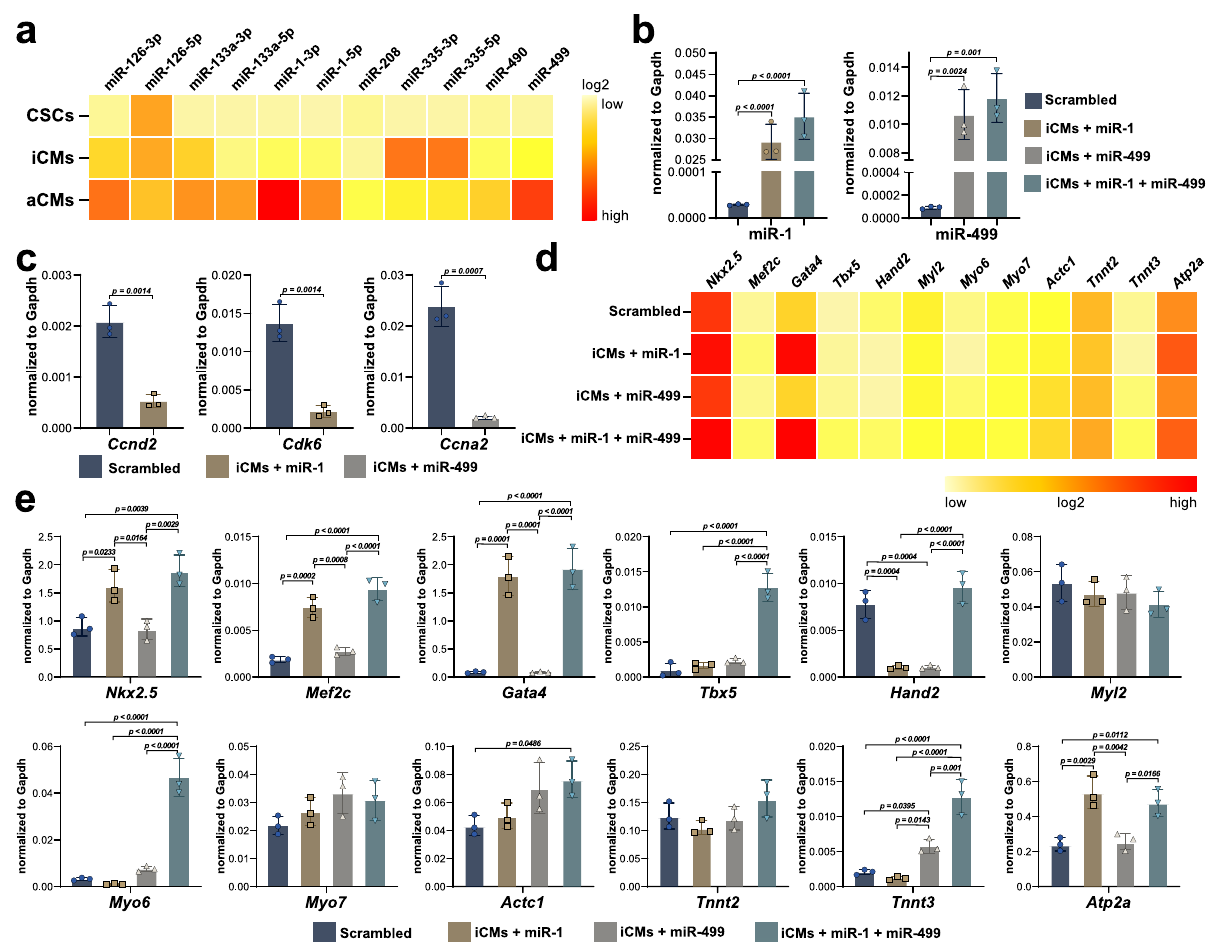
Fig. 7 miR-1 and miR-499 enhanced myogenic commitment of CSC-derived iCMs in vitro. a Heatmap showing the up-regulation of several miRNAs in aCMs. b Bar graphs showing the expression of miR-1 and miR-499 following overexpression in iCMs. c Bar graphs showing respectively, the expression of Cyclin D2 and Cdk6 , direct targets for miR-1, and the expression of Ccna2, direct target for miR-499 in iCMs transducted with the respective miRNAs. d , e Bar graphs and heatmap showing qPCR data for the expression of the main cardiac transcription factors Nkx2.5, Gata4, Mef2c, Tbx5, Hand2, Myl2, Myo6, Myo7, Tnnt2, Tnnt3, Actc1, and Atp2a in iCMs after transduction of iCMs with scrambled miR, miR-1, miR-499, and miR-1 + miR-499. The data are expressed as mean ± S.D. of biological triplicates. Each of the biological triplicate was veri fi ed by a technical